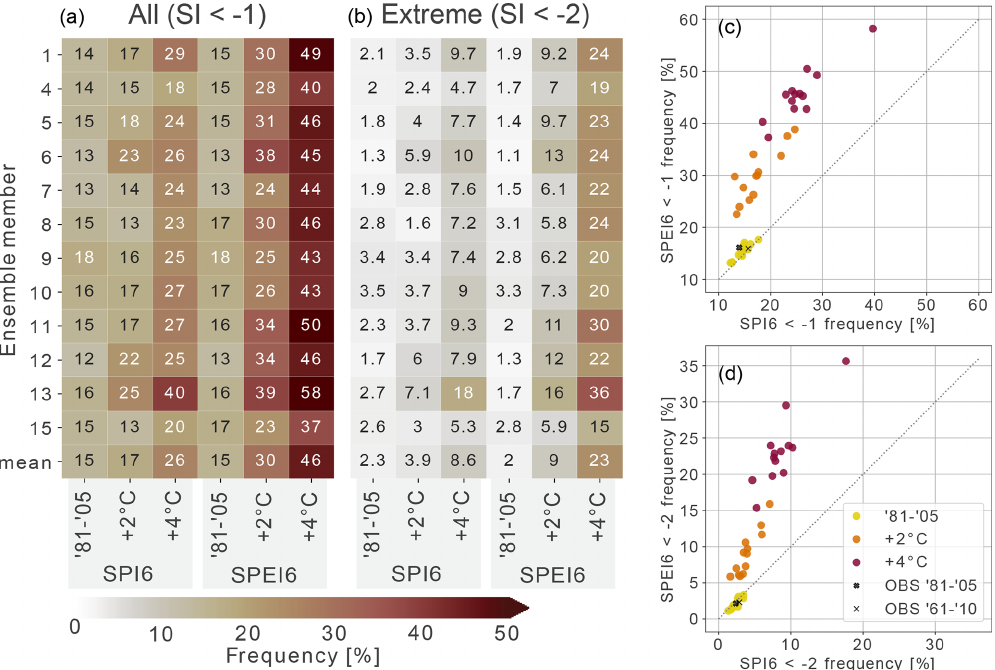
Figure 4. Spatially averaged projections of drought frequency, expressed as the fraction of months that the SI is below the threshold, for each ensemble member (rows) and the ensemble mean (bottom row), for three time slices (sub-columns) that correspond to the reference period and two different levels of global mean surface warming compared with pre-industrial levels, using both drought indices (columns). Frequencies are shown for all droughts (a) , for extreme droughts (b) , and as scatter plots (one point per ensemble member) comparing SPI6- and SPEI6-based frequencies of all droughts (c) and of extreme droughts (d) . Spatial averages are across the whole of Great Britain.